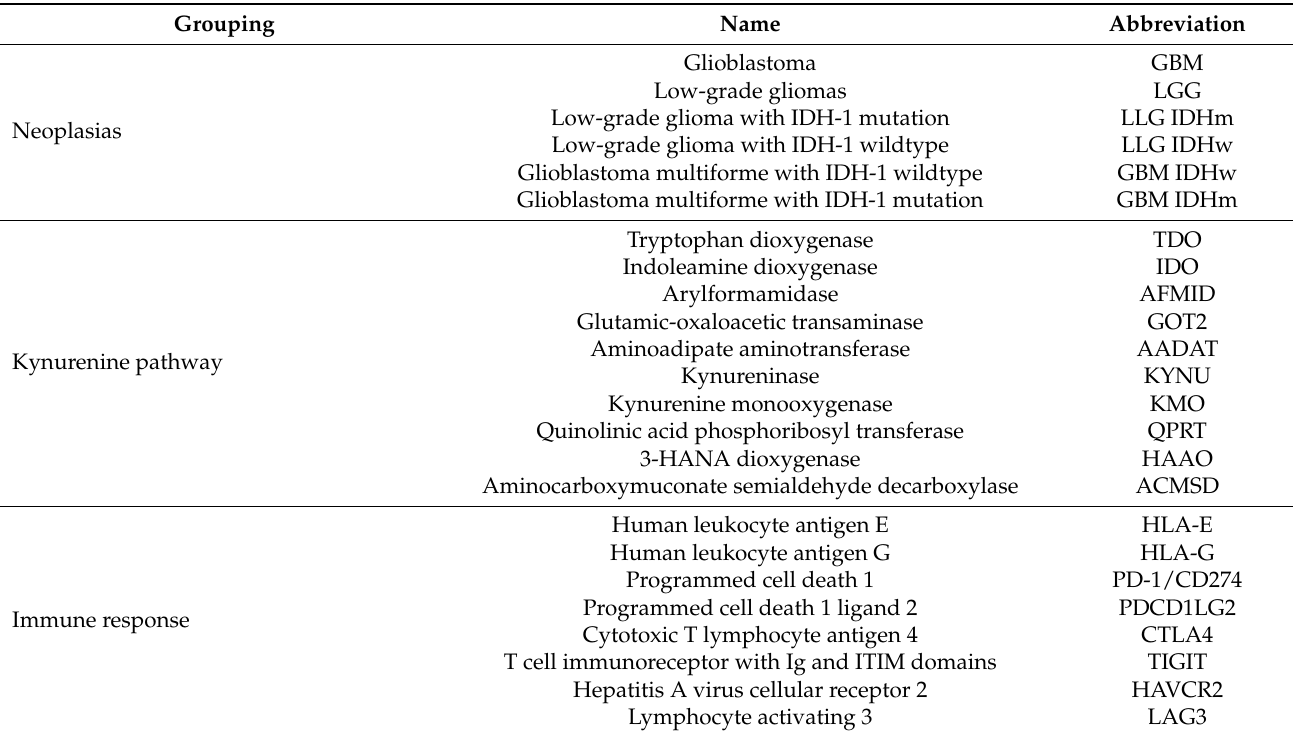
Table 1. Genes of KP enzymes and cancer